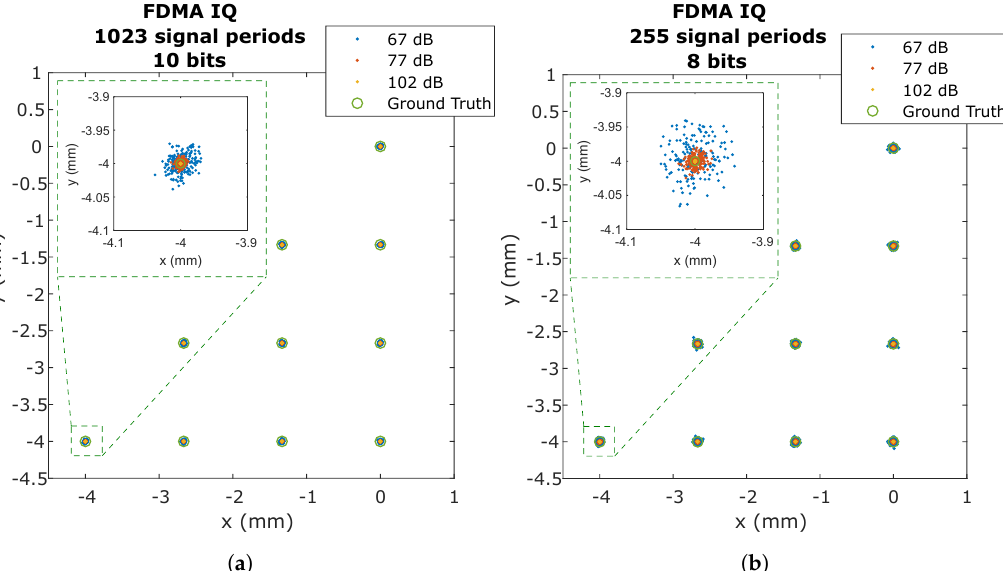
Figure 14. Impact points on the PSD for each of the positions where the receiver is positioned according to the SNR using FDMA with IQ and size of: ( a ) 10 bits; and ( b ) 8